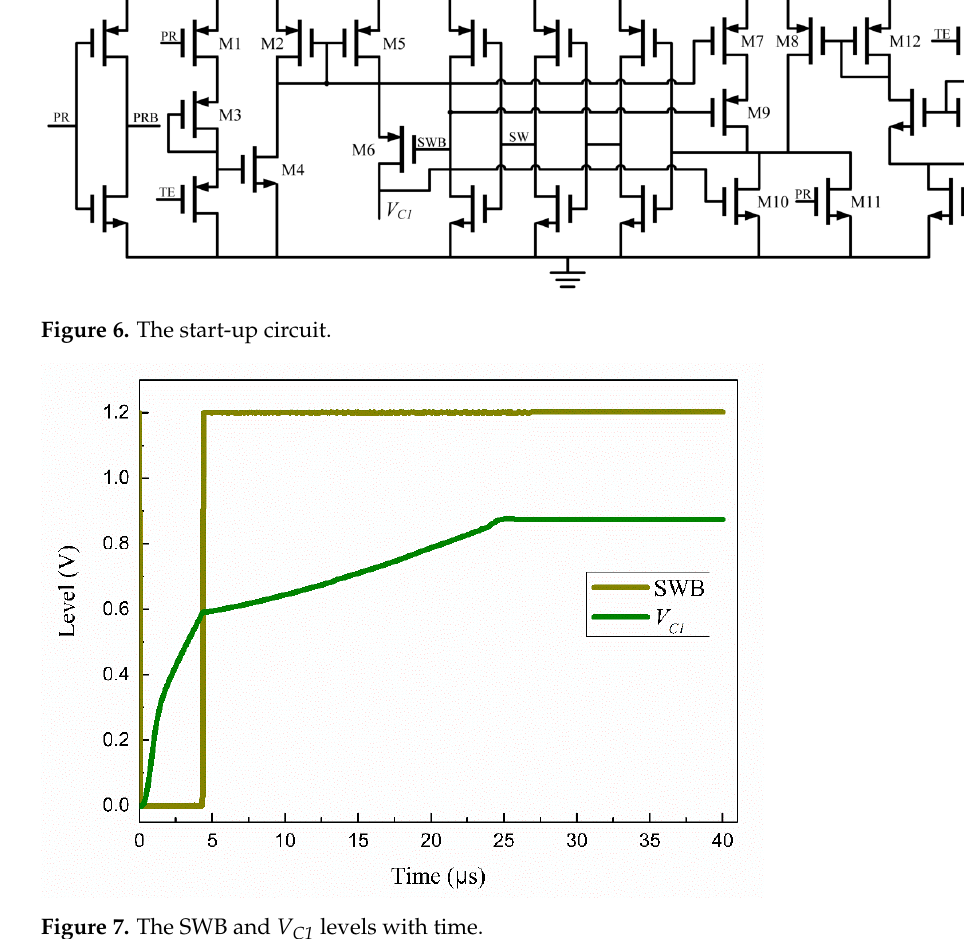
Figure 8. The lock signal with time.